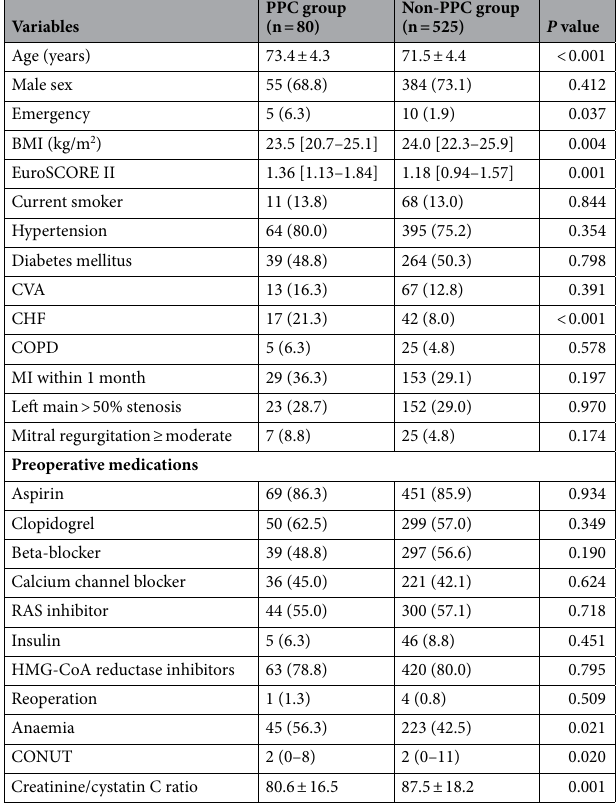
Table 1. Baseline patient characteristics. Values are presented as mean ± standard deviation, median [interquartile range], or the number of patients (percent). The CONtrolling NUTritional status score is expressed as median (range). BMI, body mass index; PPC, postoperative pulmonary complication; RAS, renin- angiotensin system; CHF, congestive heart failure; CVA, cerebrovascular accident; COPD, chronic obstructive pulmonary disease; MI, myocardial infarction; CONUT, CONtrolling NUTritional status.